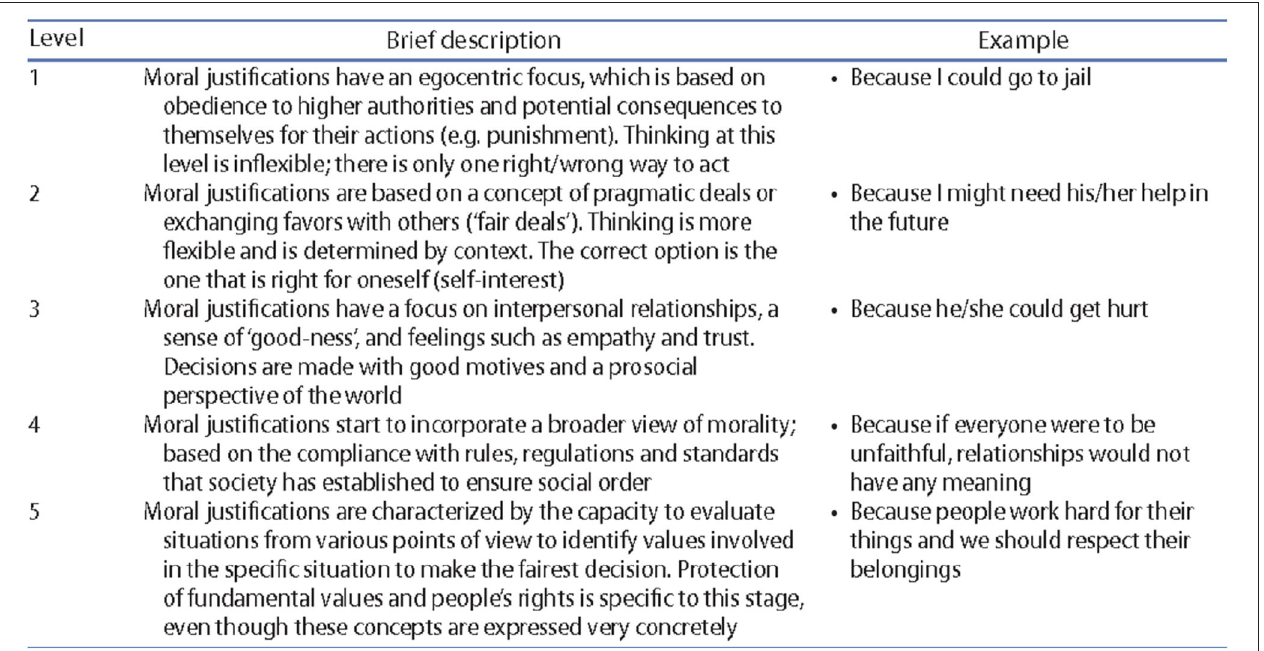
FIGURE 5 | Brief description of SoMoral coding and examples (Chiasson et al.,